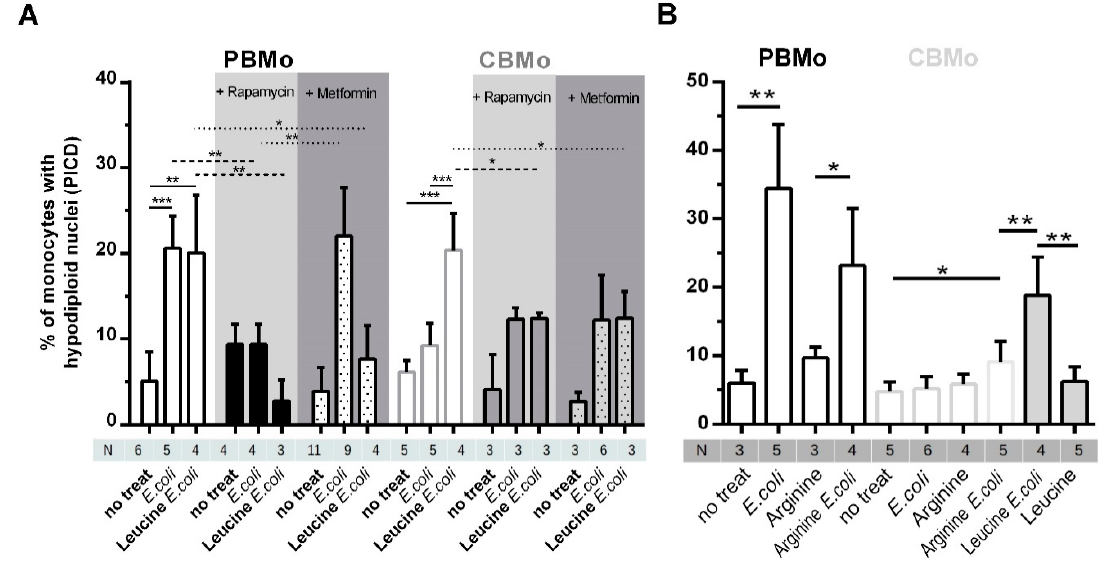
Figure 4. Leucine-Induced PICD is dependent on mTOR signaling. PICD was compared between PBMo and CBMo for the infection interval of 24 h. The multiplicity of infection was 50. Indicated groups received rapamycin (50 nM, 30 min before infection grey highlighted) or metformin (2 mmol/L 30 min before infection, dark-grey highlighted; Student’s t -test * p < 0.05; ** p < 0.01; *** p < 0.005) Indicated groups were cultured with leucine (5 µg/mL, 30 min before infection). ( B ) Comparable experimental setup as shown in ( A ). Mo were pre-incubated with l-arginine (6.5 µg/mL) and indicated groups infected with E. coli . Apoptosis was detected 24 h p.i. (Student’s t -test * p < 0.05). All charts give error bars representing the standard deviation (SD).